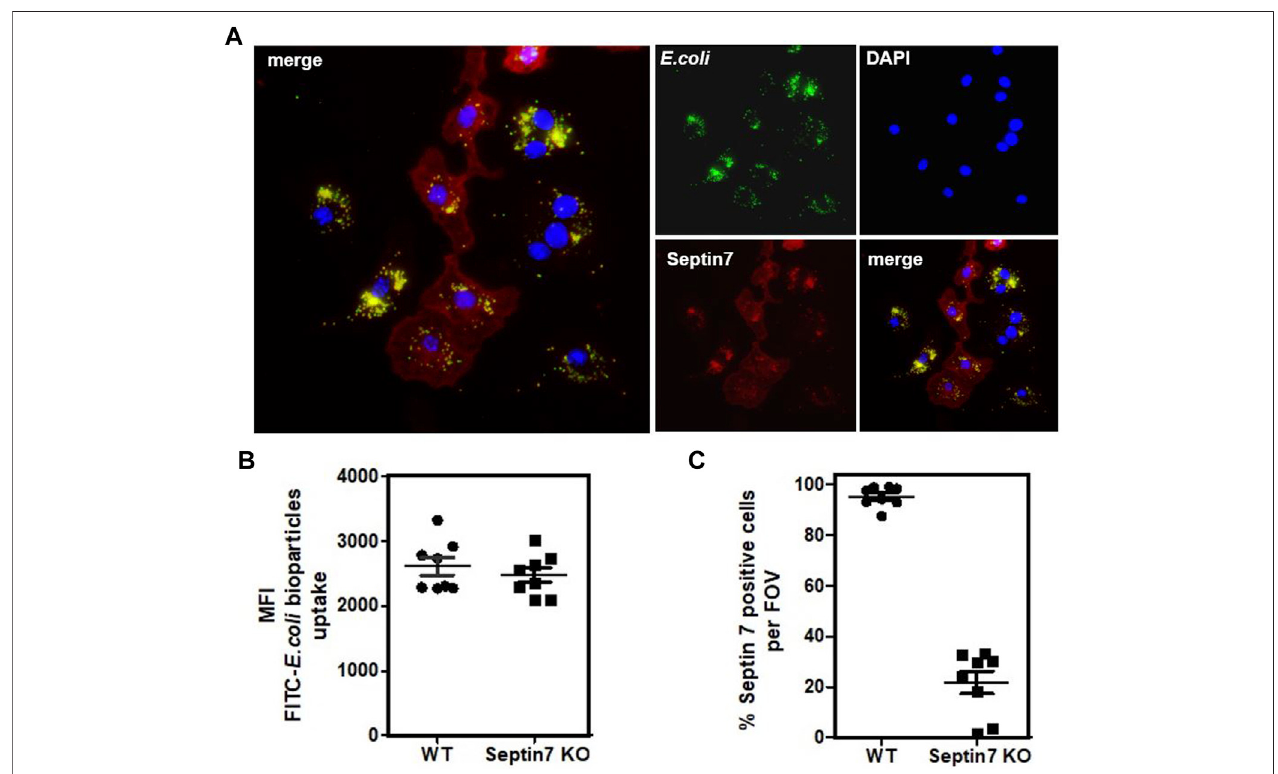
FIGURE 3 | Septin7 KO BMDMs phagocytose bacterial particles. (A) BMDMs generated from Septin7 fl ox/ fl ox :Lyz2-Cre mice BM were subjected to phagocytosis assay with fl uorescentlabeled E. coli particles (Green) and were fi xed and stained with Septin7 antibodies (Red) and DAPI (blue). Both Septin7-positive mono-nucleated cellsandSeptin7-de fi cientpredominantlymultinucleatedBMDMsef fi cientlyphagocytosethebacterialparticlesasindicatedbytheirintracellularaccumulation. (B) Semi- quantitative analysis of phagocytosed bacterial particles of WT and Septin 7 KO BMDMs — mean of green fl uorescence intensity (MFI) of phagocytosed green- fl uorescent particles isshown per cells per fi eld ofview. (C) Percentage ofSeptin7-positivecells quanti fi ed as detailed inmethodssection and shown as percentage per fi eld of view (FOV).